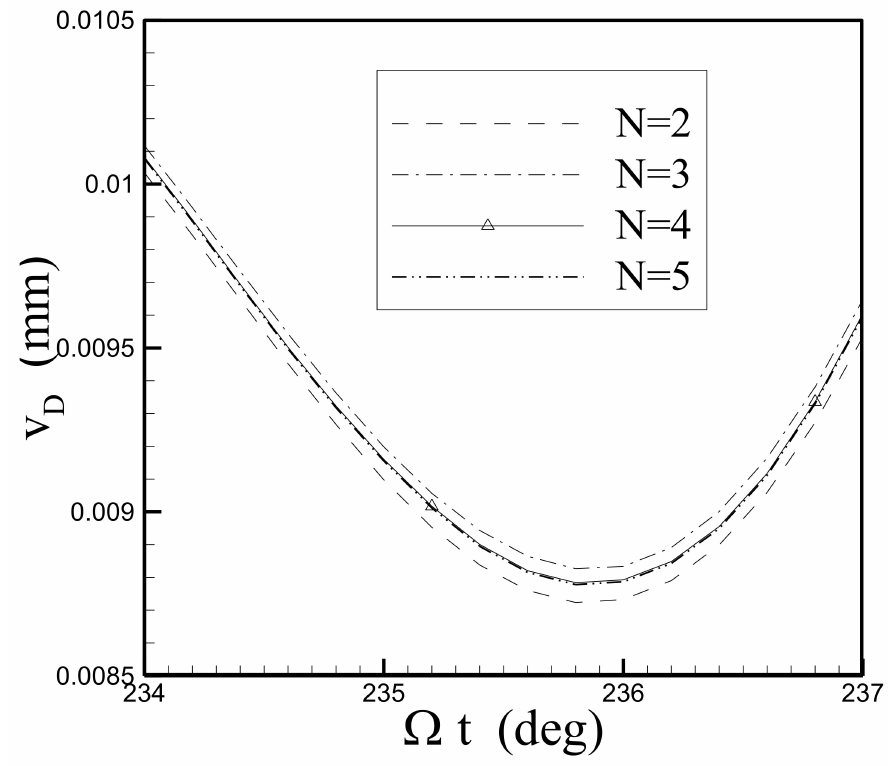
Figure 4. The time responses of the follower output node D in the lateral direction where Ω = 320 rad/s, using four mode numbers.